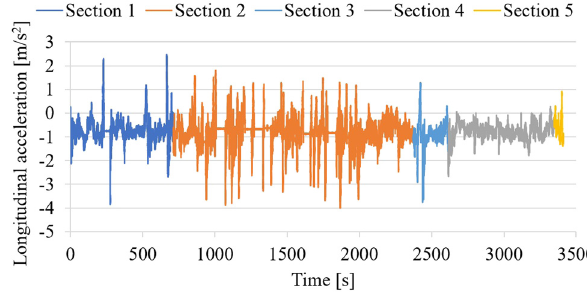
Table 1: Vehicle motion parameters – morning drive